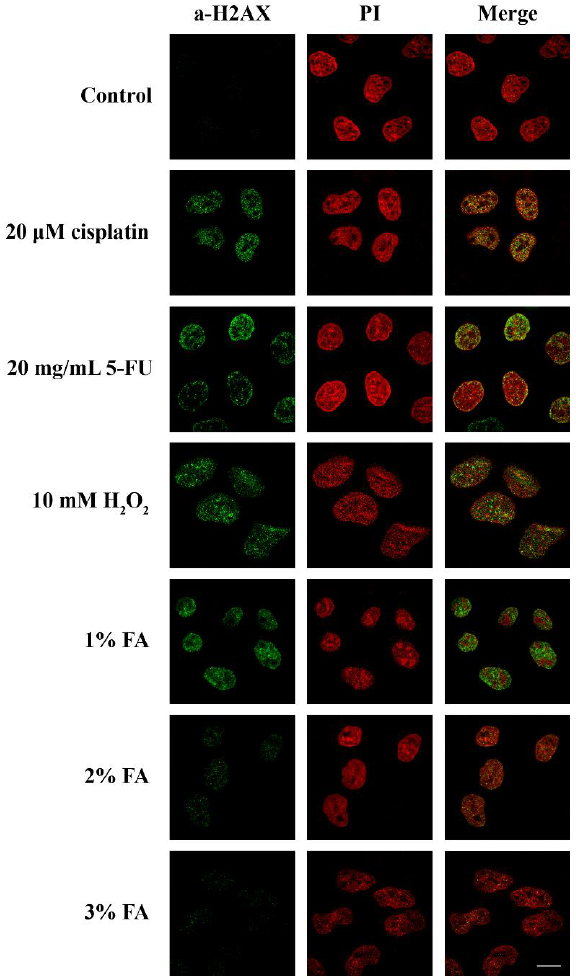
Figure 3. Stress agents and inefficient fixation induced DNA damage. Fluorescent patterns of H2AX in HeLa cells treated with 20 µM cisplatin for 24 h, 20 µg/mL 5-FU for 48 h, 10 mM H 2 O 2 for 1 h, or fixed for 5 min with 1%, 2%, or 3% FA. H2AX was detected using the anti-phospho-histone H2AX (Ser139) monoclonal antibody (Millipore), while nuclei were stained with PI. Scale bar: 10